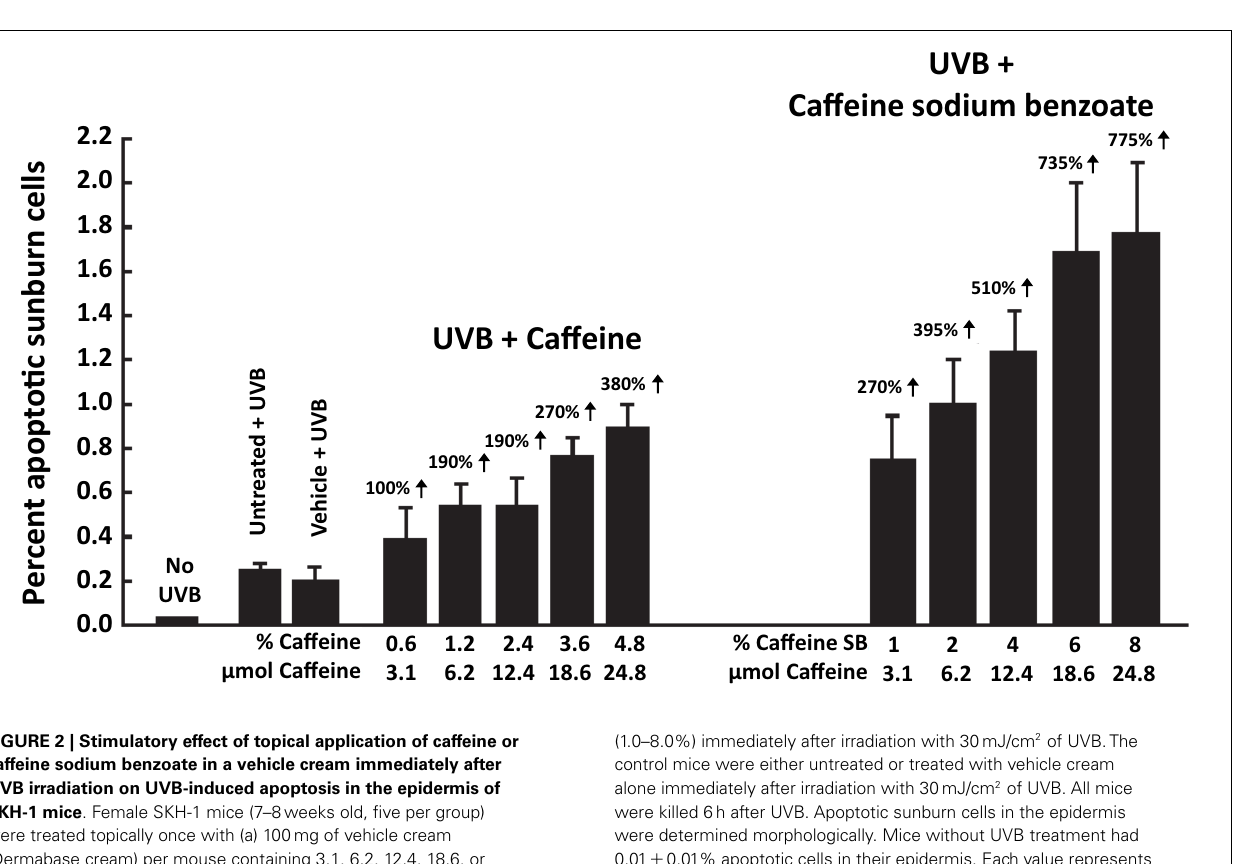
FIGURE 1 | Inhibitory effect of topical application of caffeine or caffeine sodium benzoate (caffeine-SB) prior to UVB irradiation on UVB-induced formation of thymine dimers and sunburn lesions in the epidermis of SKH-1 mice . In (A) , female SKH-1 mice (7–8weeks old; five per group) were untreated or treated topically with 100mg of vehicle cream (Dermabase cream), or with caffeine or caffeine-SB (24 µ mol) in vehicle cream 0.5h before a single irradiation with UVB (180mJ/cm 2 ).The animals were killed just before UVB (“0h”) or at 0.5, 2, 6, 10, 16, 24, or 48h after UVB and thymine dimer positive cells in the epidermis were measured. In (B) , female SKH-1 mice